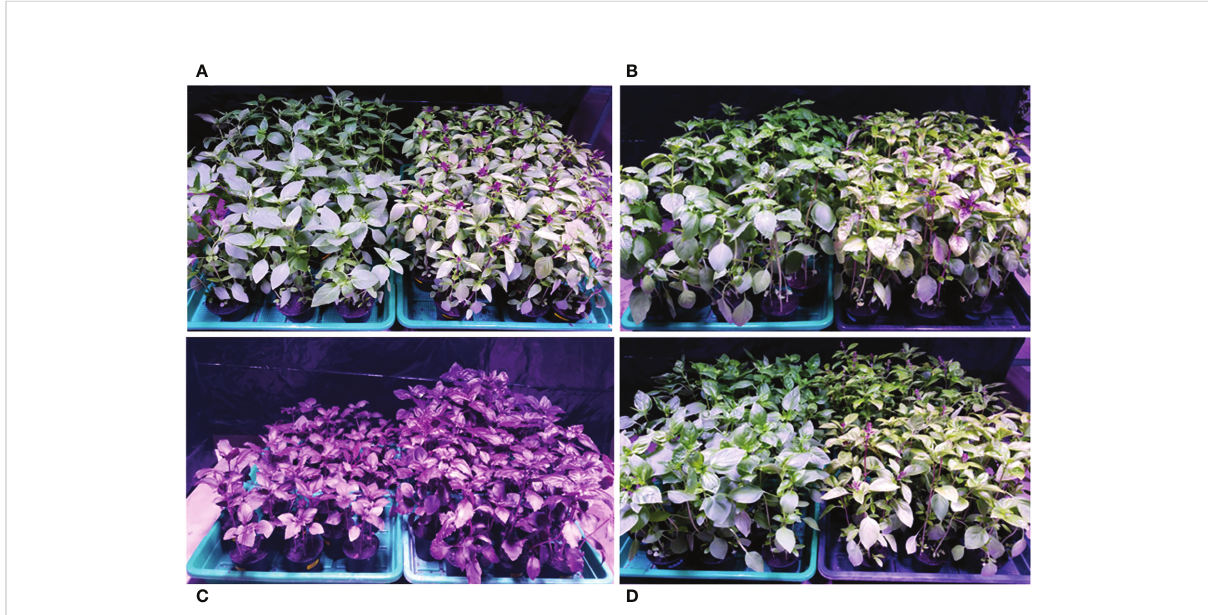
FIGURE 4 Visual appearance offour Ocimum basilicum L. cultivars at harvest. (A) O. basilicum L. cv. ‘ Anise ’ , (B) O. basilicum L. cv. ‘ Cinnamon ’ , (C) O.